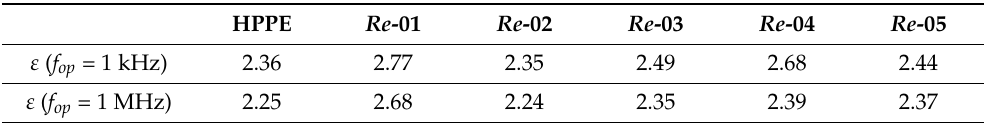
Table 5. Results of measurements of ε of rhenium-containing composites at frequencies of 1 kHz and 1